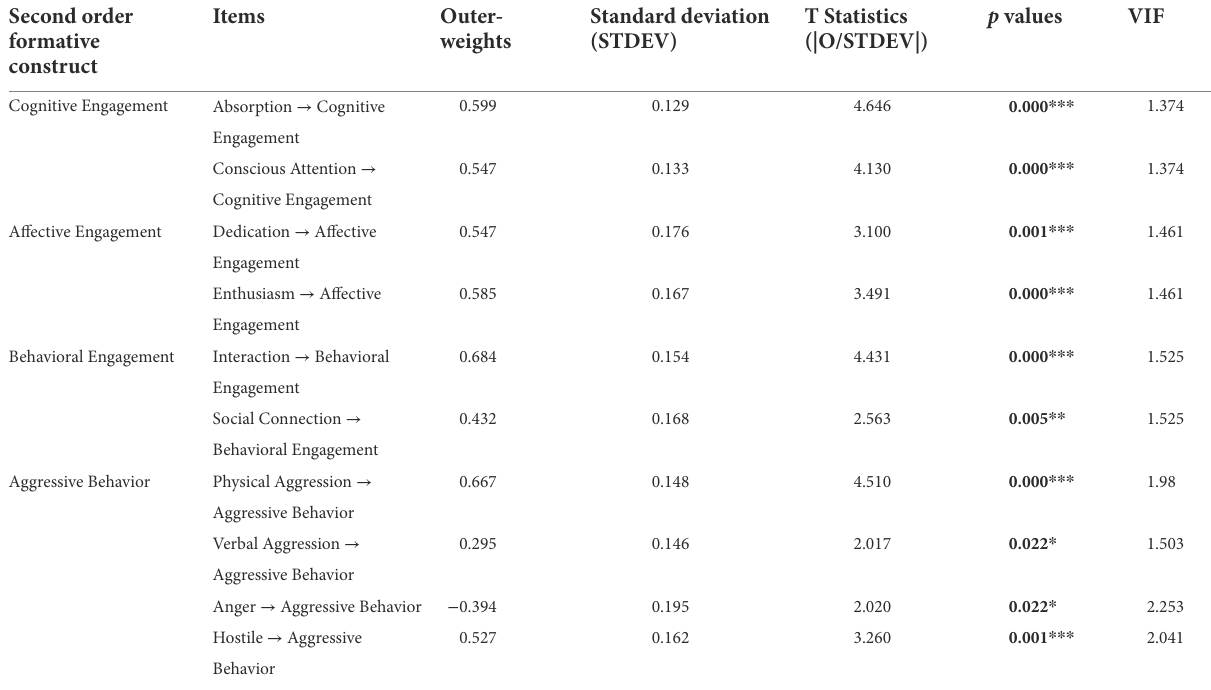
TABLE 4 Validity tests second-order